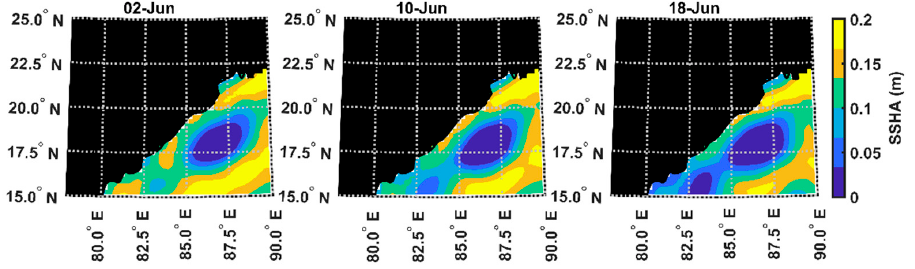
Figure 14. Decadal Climatology (2009 to 2018) of unfiltered negative SSHA in the northwestern BoB during the first downwelling Kelvin wave period.